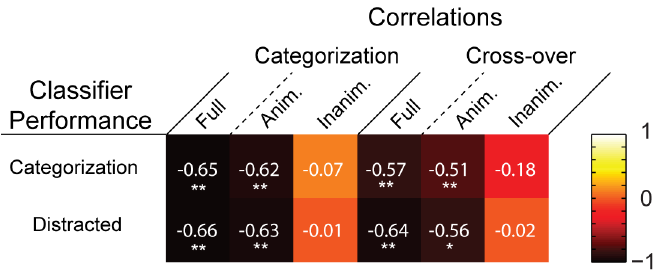
Fig 5. Matrix of correlations between decoding time-courses and representational distance-RT correlation time-courses. The “ heat ” of each tile reflects the strength of the rank-order correlation (Spearman ’ s ρ ) between a decoding time-course and a representational distance-RT correlation time-course. Asterisks indicate significant correlations ( * = p < .01; ** = p < .001).